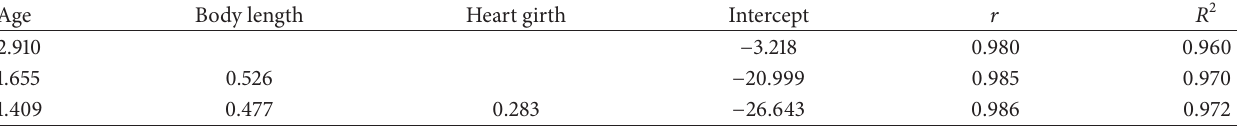
Table 2: Stepwise multiple linear regression prediction of live weight from body measurements ( 𝑛 = 202 ).